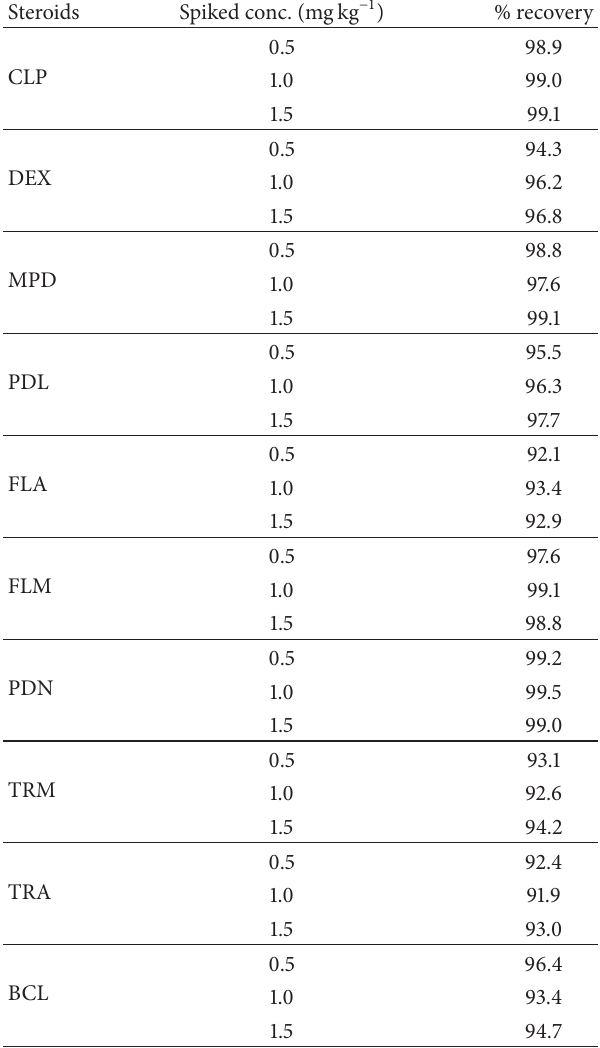
Table 3: Validation data of recovery for samples containing spiked standard solutions in blank cosmetic